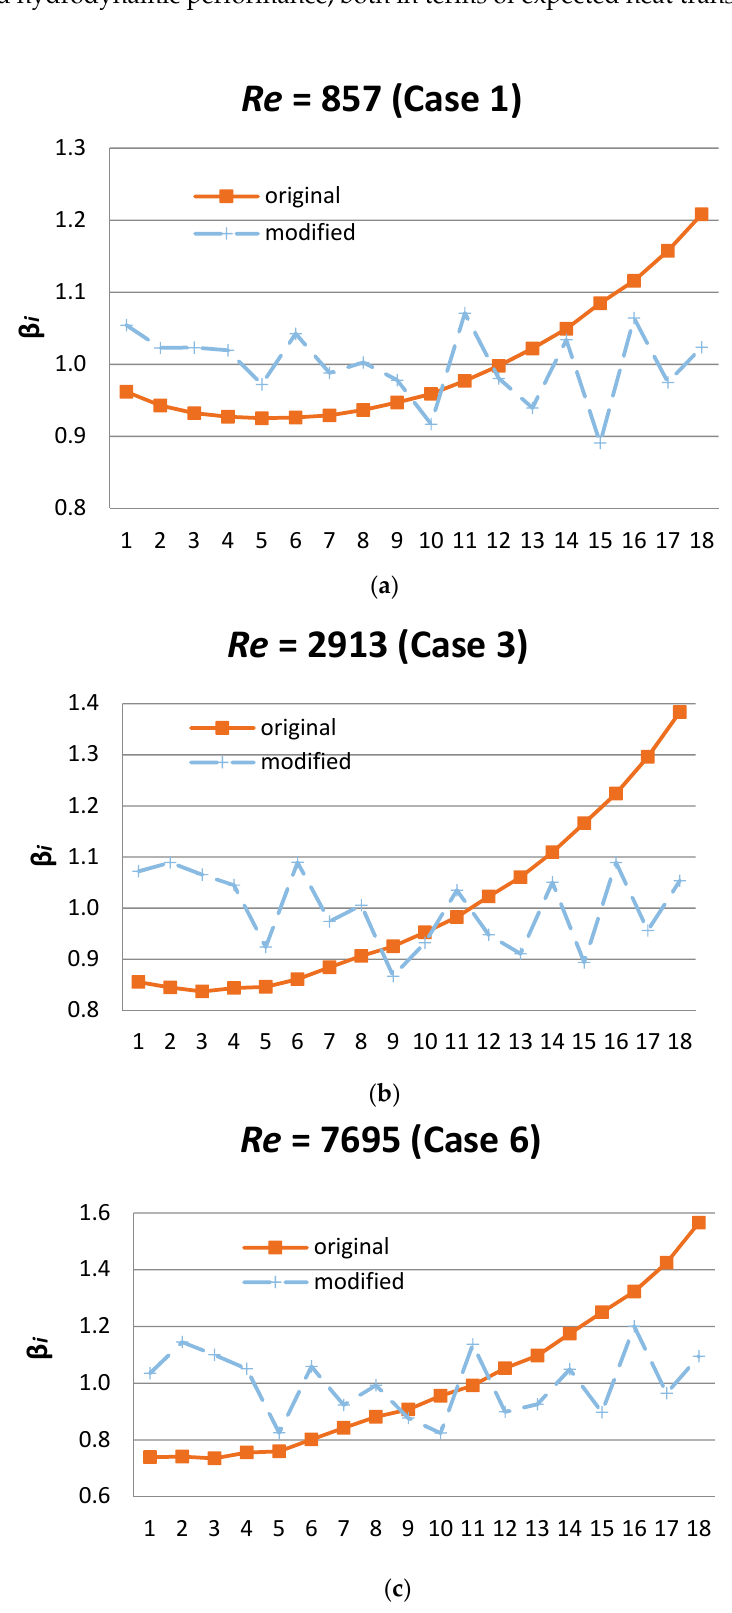
Figure 10. Comparison of predicted flow distribution in the initial and modified collector geometries. ( a ) Re = 857 (Case 1); ( b ) Re = 2913 (Case 3); ( c ) Re = 7695 (Case 6).